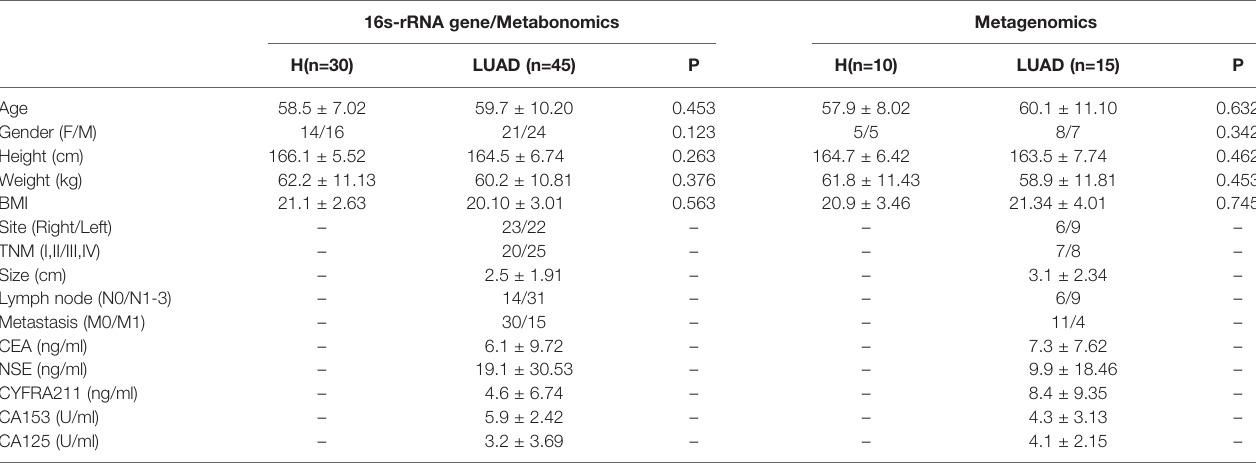
TABLE 1 | The basic information of all